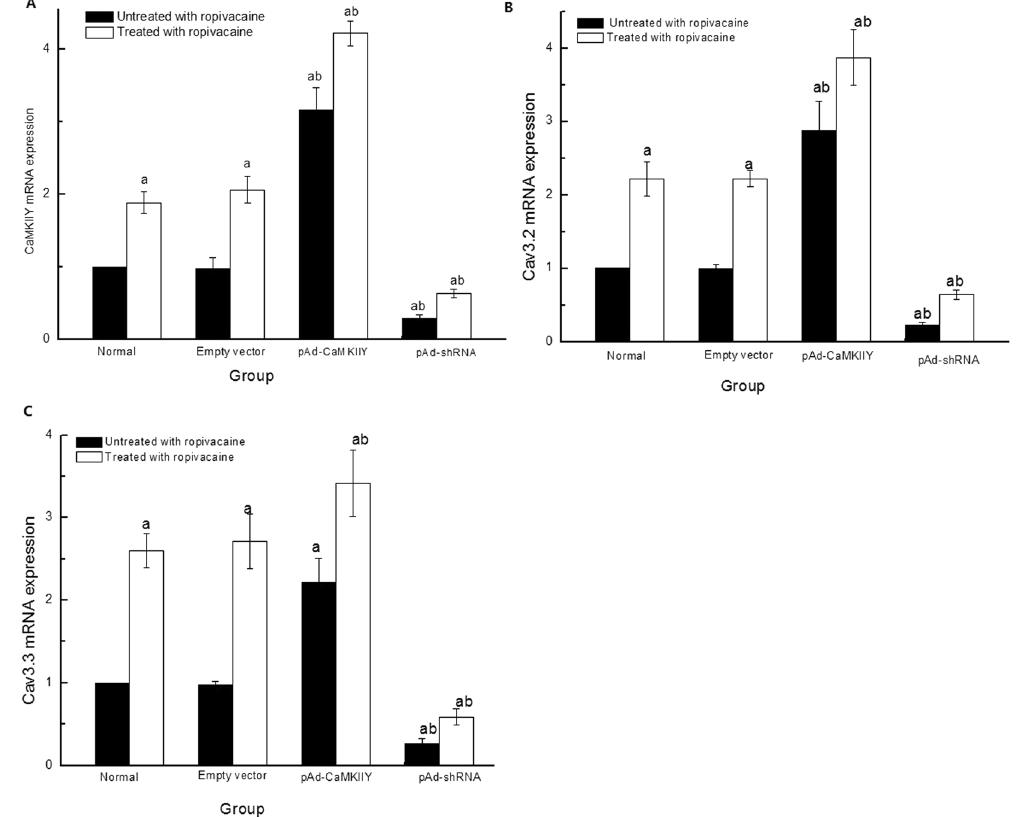
Figure 5. CaMKII γ , Cav3.2 and Cav3.3 mRNA expression ( x ± s, n = 6). ( A ) CaMKII γ mRNA expression; ( B ) Cav3.2 mRNA expression; ( C ) Cav3.3 mRNA expression. a P < 0.05 vs. Normal group; b P < 0.05 vs. Normal + R